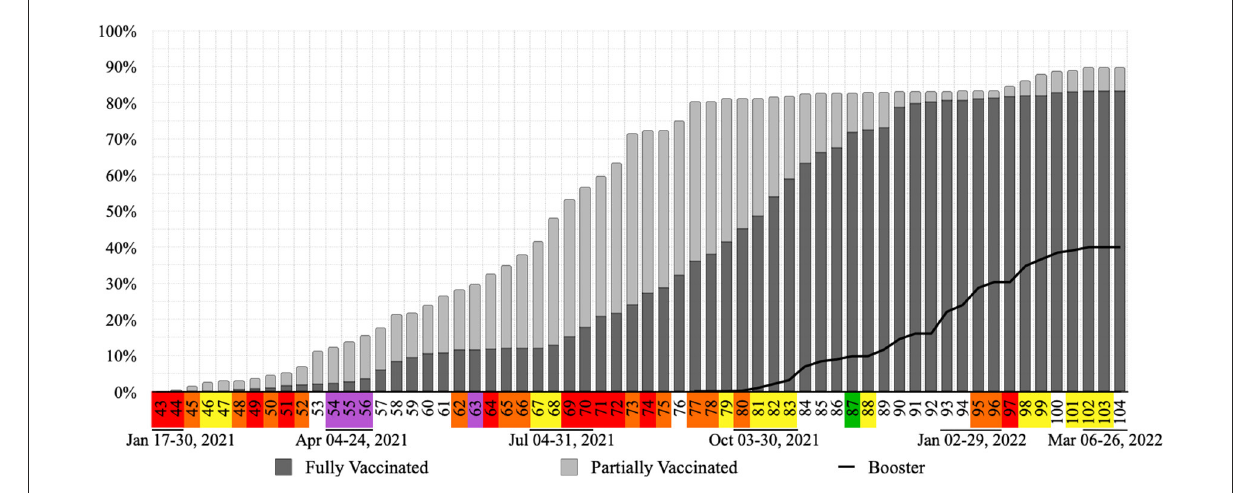
FIGURE10 Accumulated vaccination rates per week in Nova Friburgo. Flag colors: yellow, low; orange, moderate; red, high; purple, very high